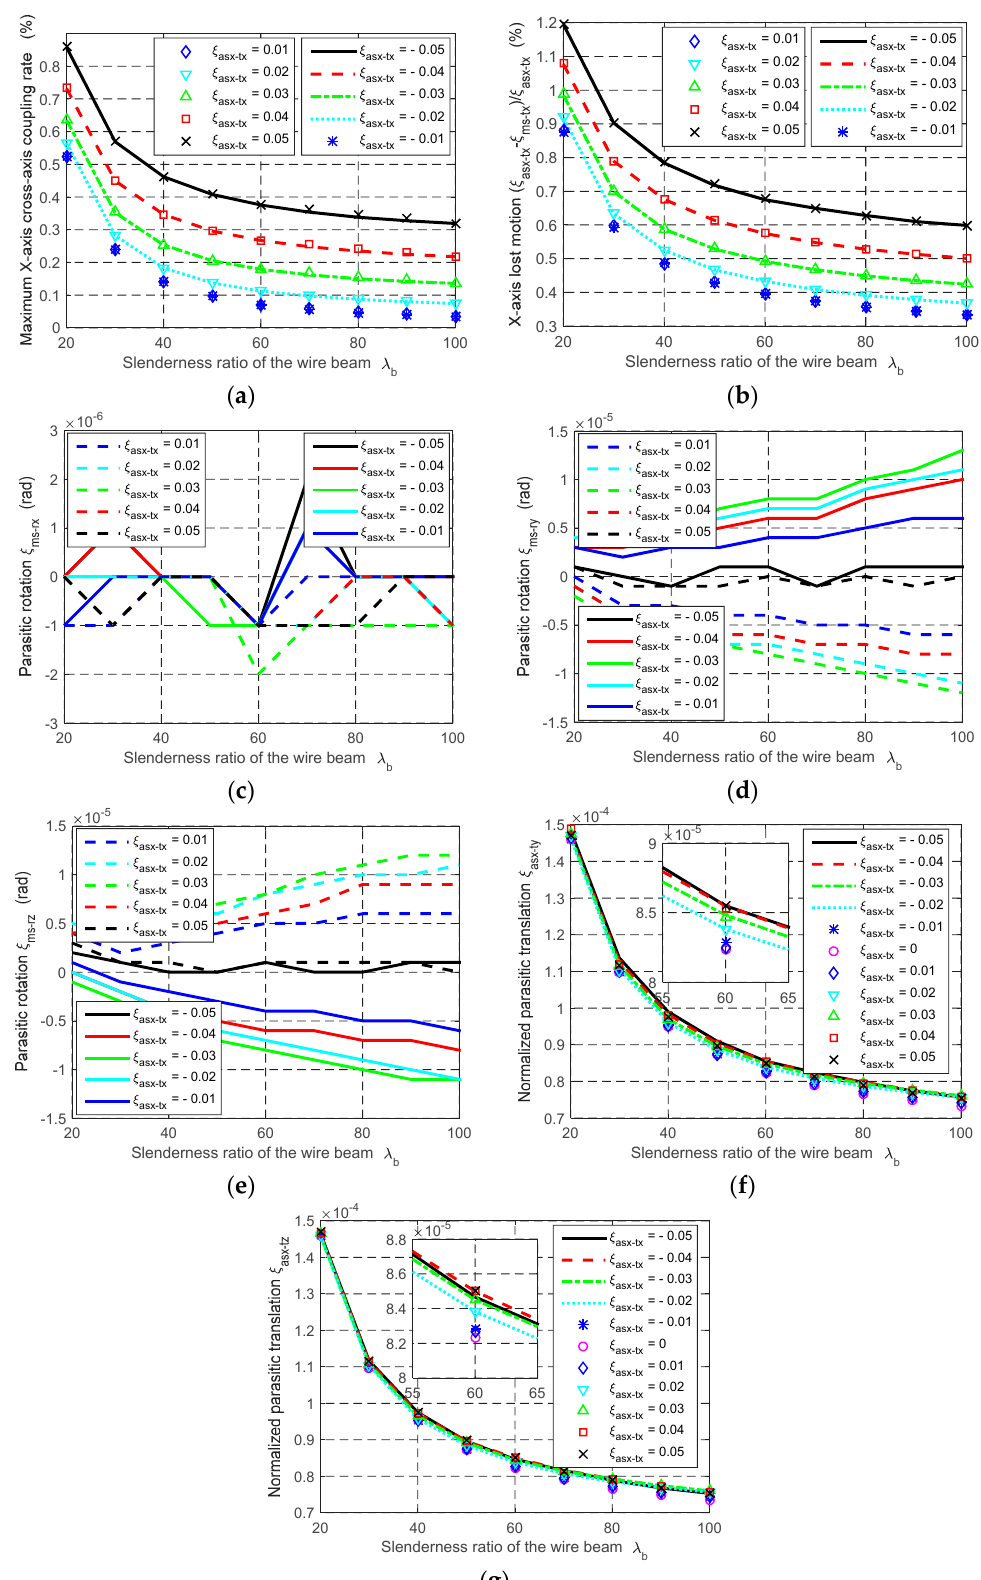
Figure 7. The variation of the motion characteristics of the XYZ CPM with the beam slenderness ratios λ b : ( a ) Cross-axis coupling rate in terms of the X-axis primary translation of the MS, ( b ) lost motion rate along the X-axis, ( c – e ) parasitic rotations of the MS about the X-, Y- and Z-axes, respectively and ( f – g ) parasitic translations of the AS along the Y- and Z-axes, respectively.